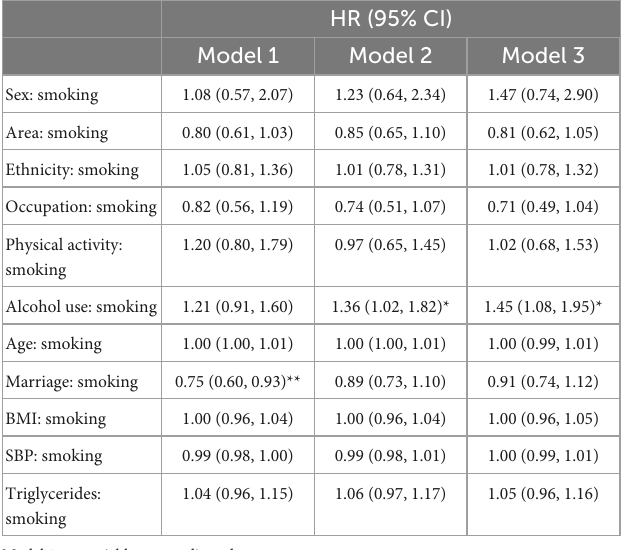
Model1:novariableswereadjusted. Model2:adjustedforage(continuousvariable)andsex. Model 3: model 2 plus area, ethnicity, marriage, occupation, alcohol use, physical activity, history of diabetes, SBP, total cholesterol, triglycerides, HDL-C value, LDL-C value, and baselineBMIvalue. ** P < 0.01,* P <